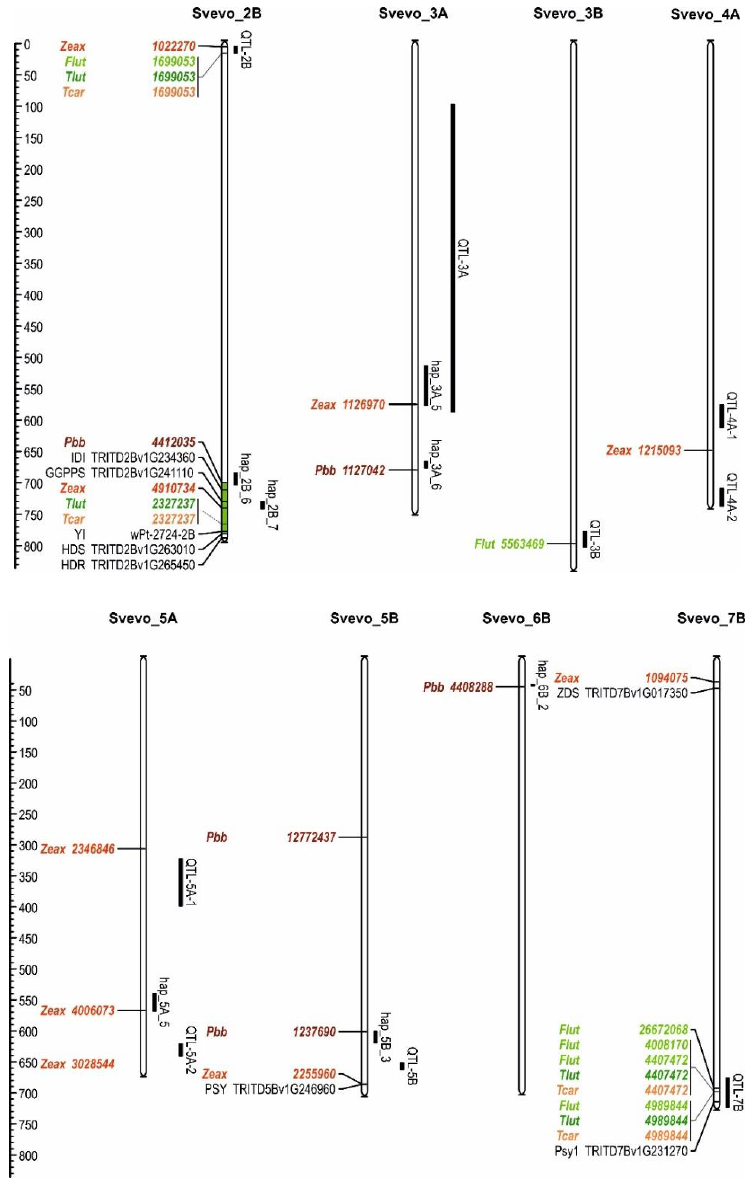
Figure 5. Co-localization of marker-trait associations identified in this work with previous QTLs for yellow pigment content (YPC) and semolina yellowness (YI). Regions identified as ‘QTL’ were depicted according to their position at the ‘Svevo’ genome browser [37]. Haplotype regions associated to semolina pigment [44] were identified as ‘hap’ regions. The MTA between wPt-2724-2B and Yellow index was reported by [45]. Trait abbreviations: Tlut: Total lutein; Flut: Free lutein; Tcar: Total carotenoids; Zeax: Zeaxanthin; Pbb: Relative proportion of carotenoids from the β,β -branch relative to the total carotenoid pool.